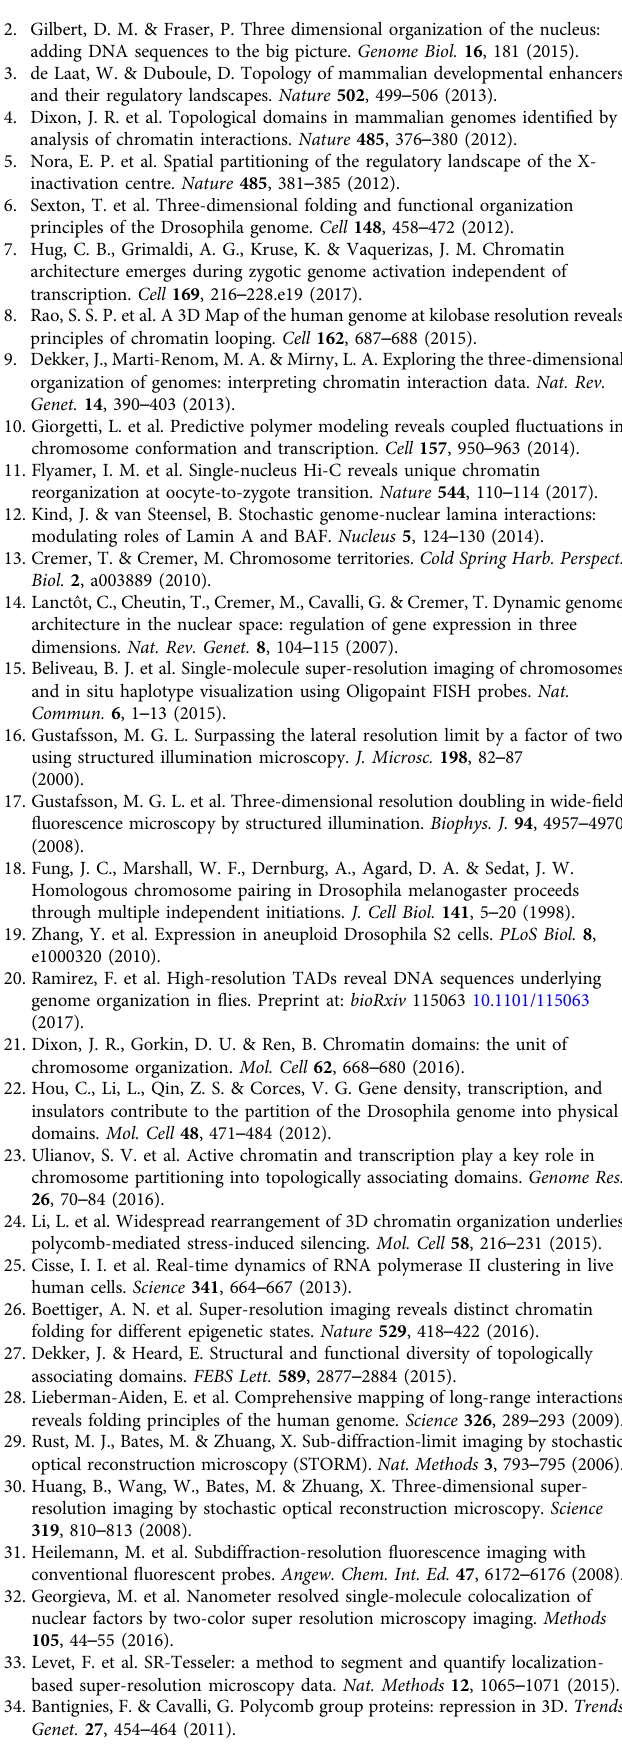
Supplementary Fig. 1. Calculation of the genomic size distributions of H3K27me3 and H3K4me3 domains (Supplementary Fig. 6) was performed as follows: (1) ChIP-chip/seq computed peaks were downloaded from ModEncode (ftp://data. modencode.org/D.melanogaster/) 60 . Data sets used are described in